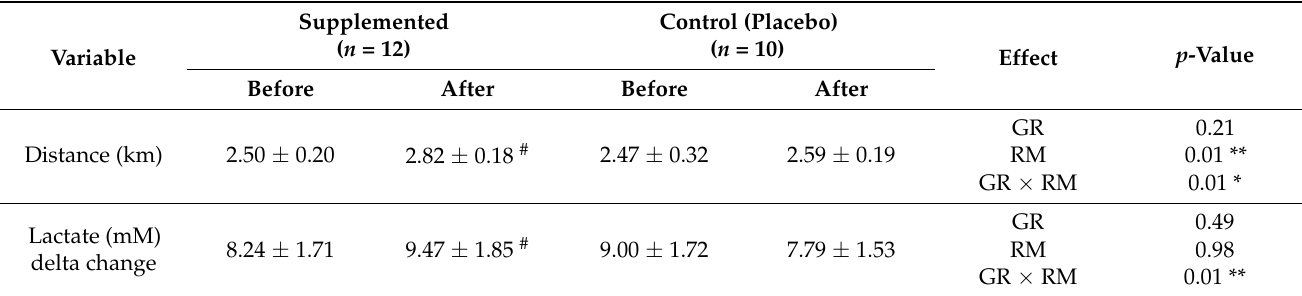
Table 3. Participant performance in maximal multistage 20 m shuttle run test before and after supplementation with a lyophilizate of black chokeberry extract (mean ± SD).